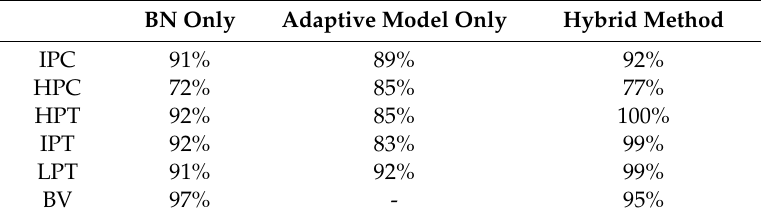
Table 7. Detection and isolation accuracy with production